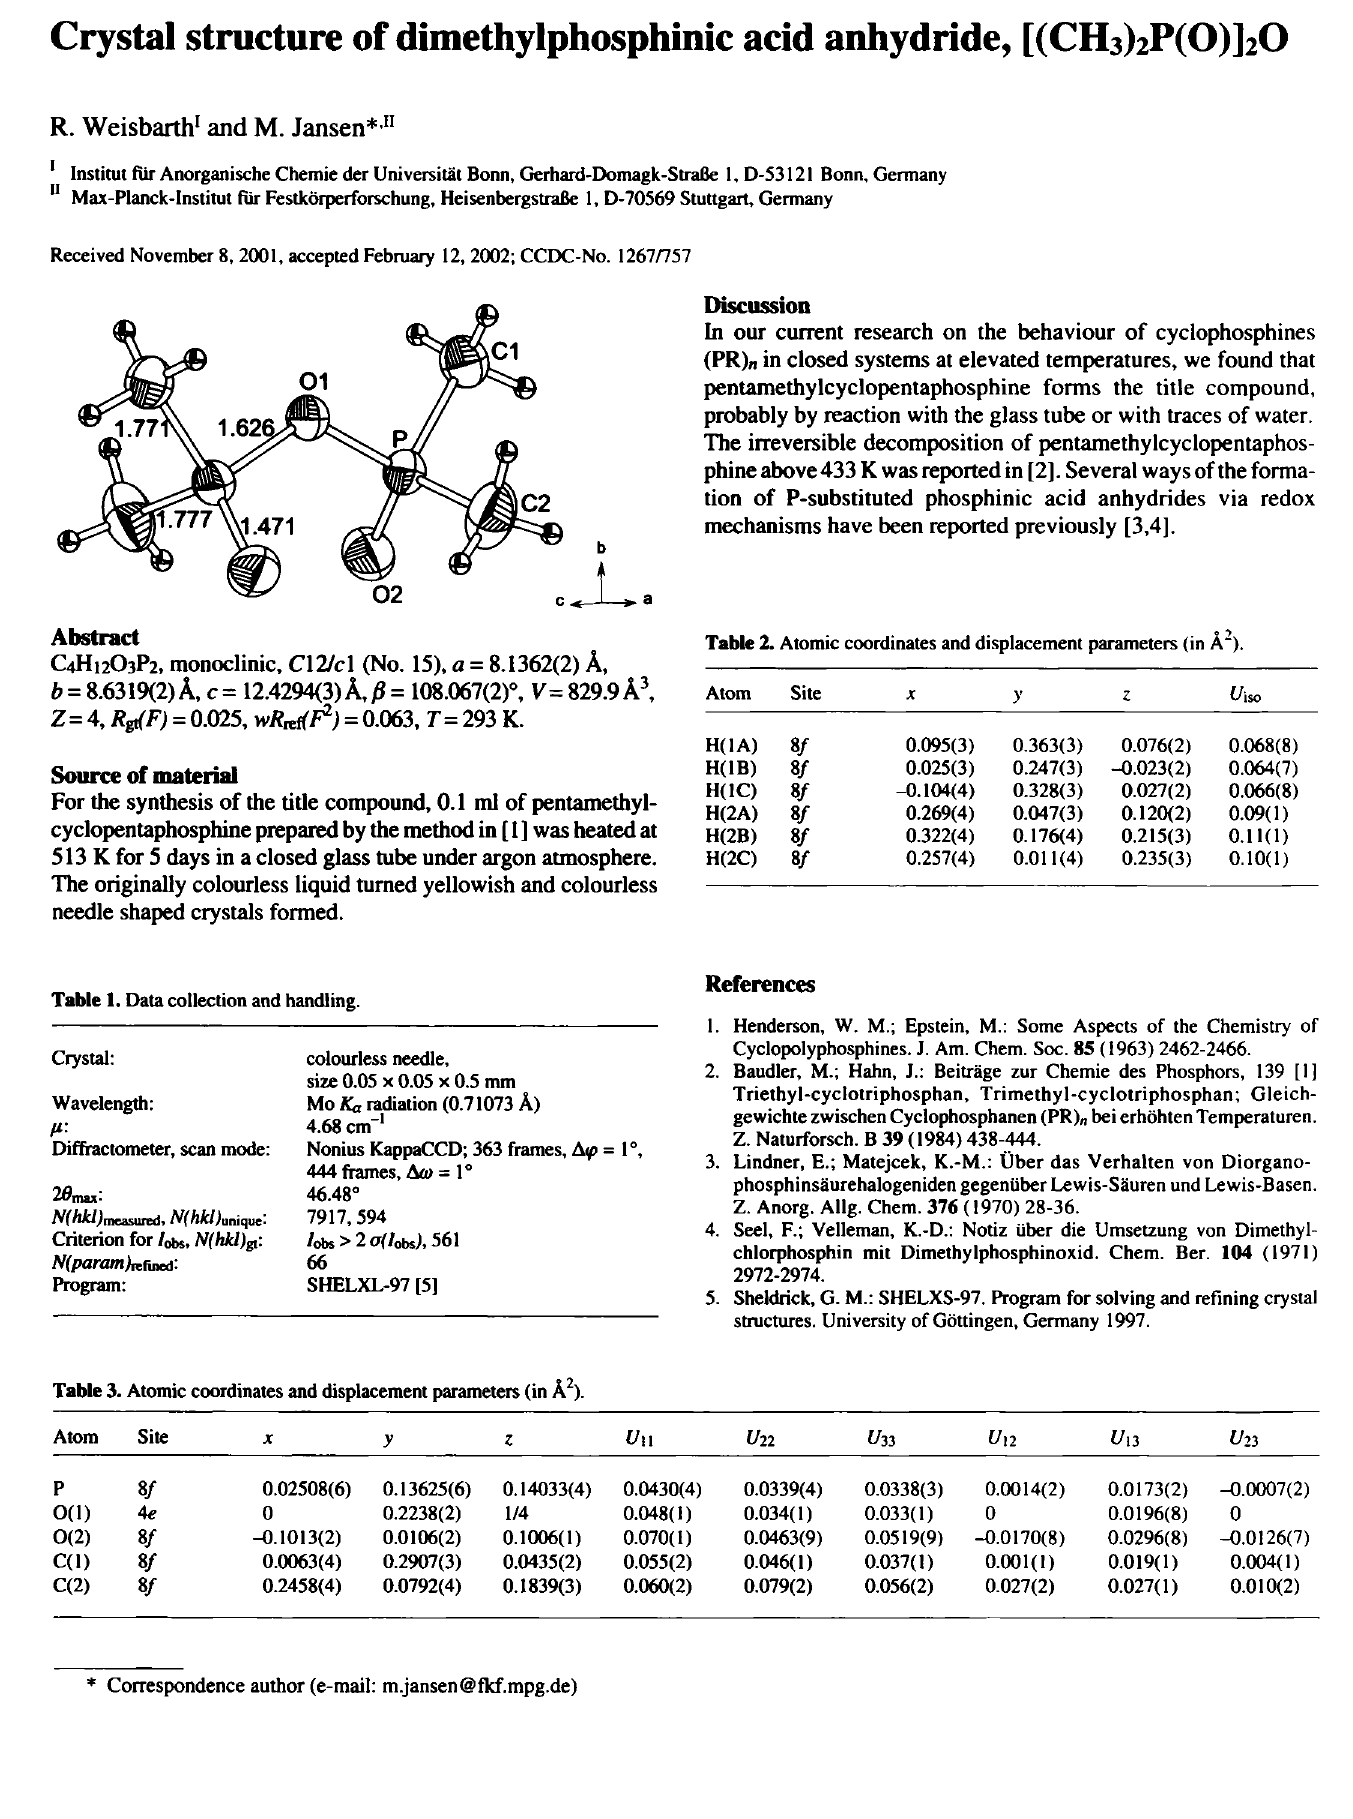
Table 2. Atomic coordinates and displacement parameters (in λ 2 ).